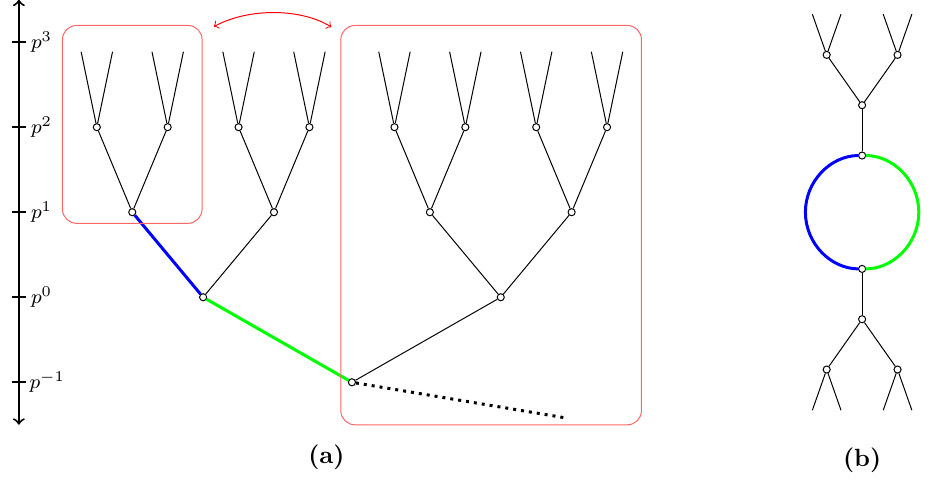
Figure 11. The torus can be constructed by excising a ball around 0 and a toroidal region. This is equivalent to identifying the boxed regions of the BT tree shown in (a). The resulting graph is shown in